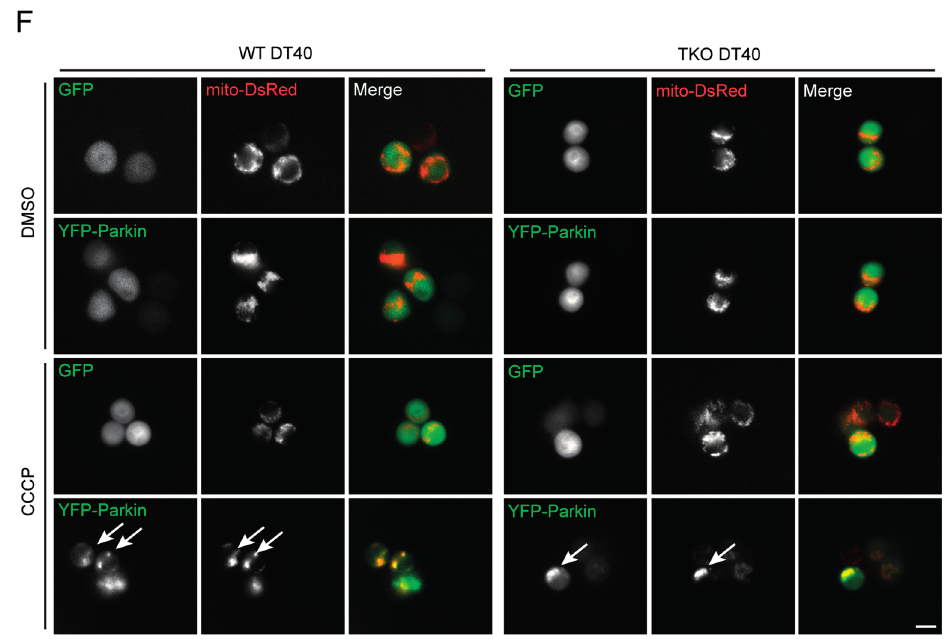
Figure 7. Effect of IP3R depletion on LC3 lipidation and Parkin recruitment to damaged mitochondria. ( A ) Immunoblot of LC3 lipidation in WT and TKO-DT40 cell lysates treated with Bafilomycin A1 for 2 h; ( B ) Quantitation of basal LC3 lipidation in WT and TKO-DT40 cells ( n = 3; means ± SD; ns = not significant, t -test); ( C ) Quantitation of LC3 lipidation in WT and TKO-DT40 cells treated with Bafilomycin A1. ( n = 3; means ± SD; * p < 0.05 2-way ANOVA Bonferroni post -test); ( D ) Immunoblot and ( E ) quantitation of LC3 lipidation in WT and TKO-DT40 cell lysates treated with increasing concentrations of CCCP for 1 h ( n = 3; means ± SD); ( F ) YFP-Parkin recruitment to damaged